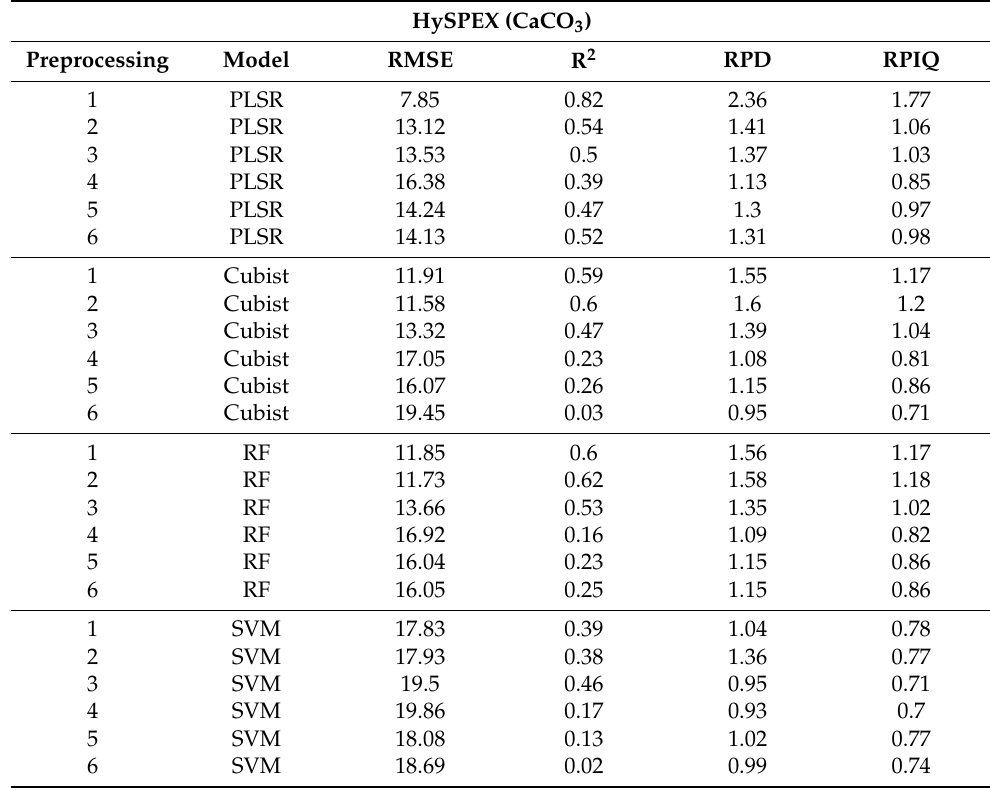
Table A5. Statistical evaluation of the models used to predict the calcium carbonate content (CaCO 3 ) from the HySpex